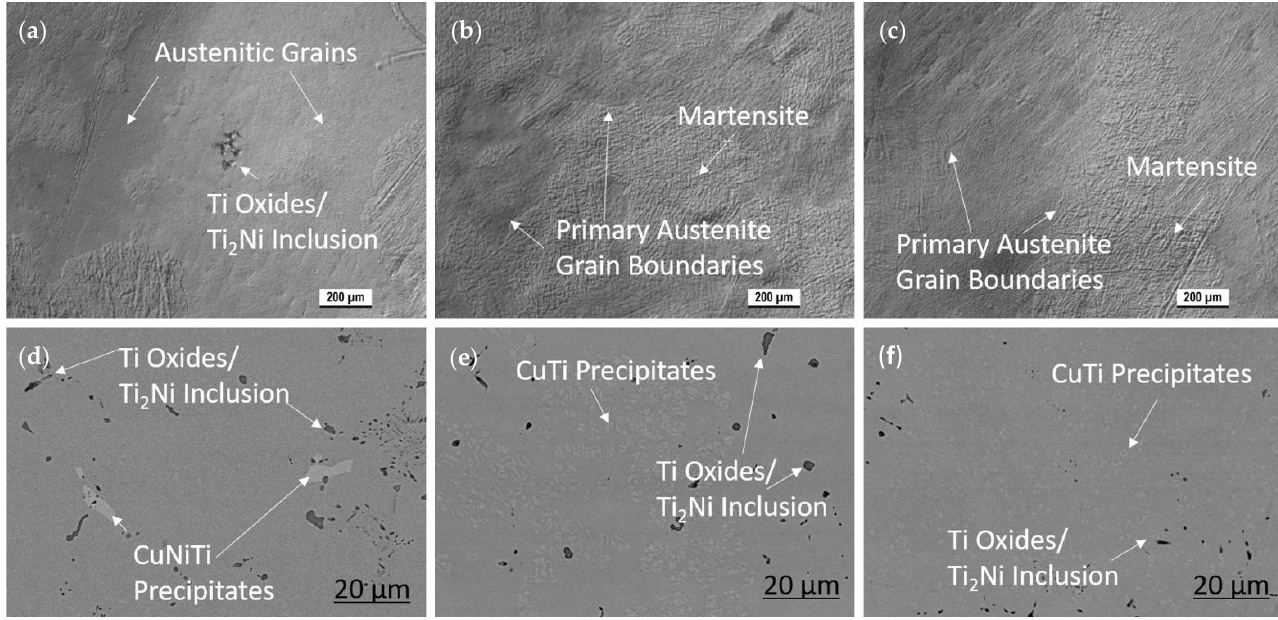
Figure 3. The microstructure of homogenized (900 °C × 24 h, Furnace cooled) group A VIM alloys: Optical and SEM micrographs of the ( a , d ) Ti-lean; ( b , e ) Ti50; and ( c , f ) Ti-rich alloys, respectively.